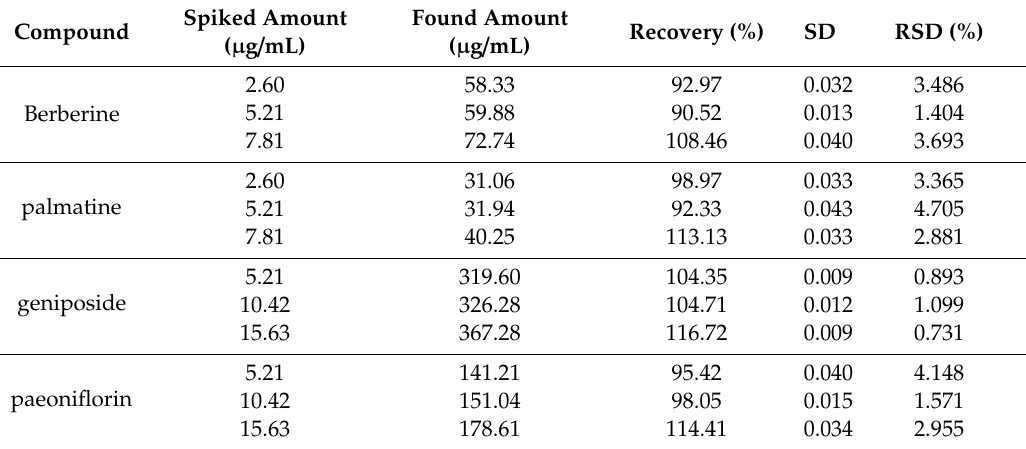
Table 3. Recoveries of the four compounds in Haedoksamul-tang (HST) samples ( n = 3). Spiked Amount Found Amount Compound ( µ g / mL) Berberine